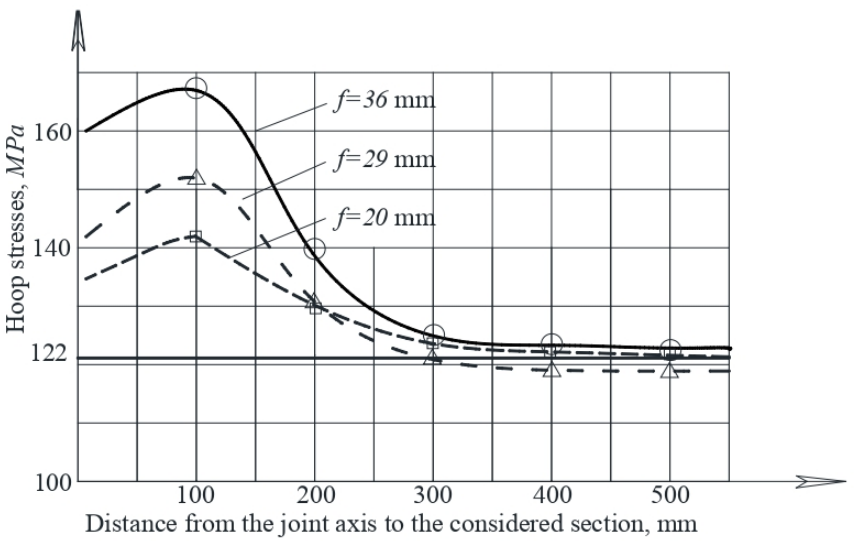
Figure 12. The hoop stress diagrams in the tank wall field joint zone with a volume of 3000 m 3 with bend: 我 f = 20 mm; 你 f = 29 mm; ○ f = 36mm.